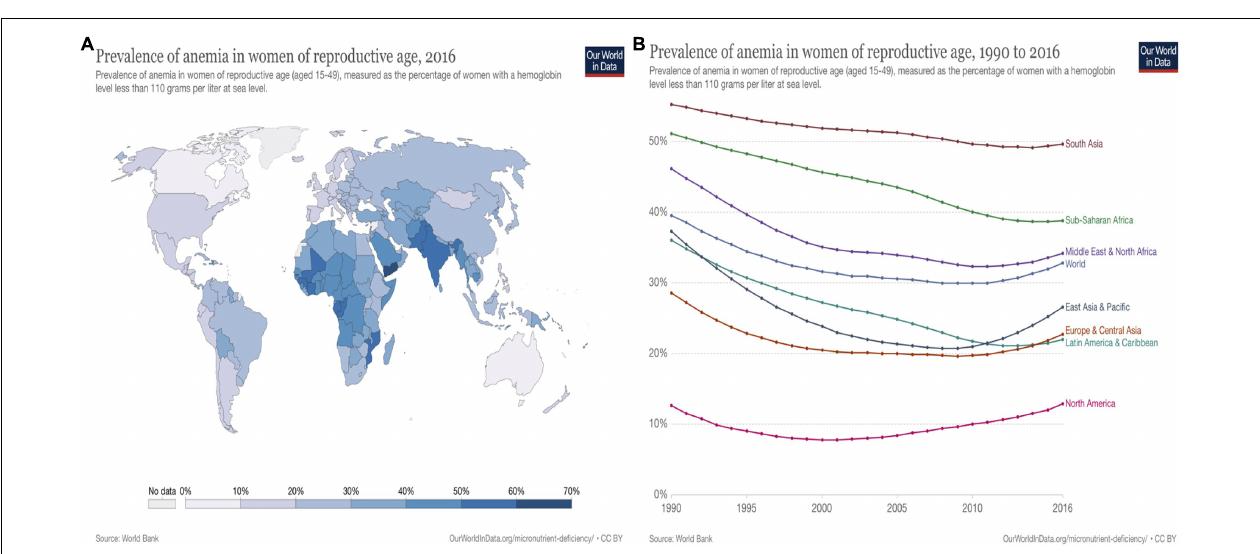
FIGURE 3 | Vitamin B12/Iron deficiency: Anemia prevalence in women of reproductive age worldwide (Source: WorldBank; Ritchie and Roser, 2017). (A) Vitamin B 12 /Iron deficiency: anemia prevalence in women of reproductive age worldwide, 2016. Anemia (vitamin B 12 /Fe deficiency) in women of reproductive age (aged between 15 and 49) mainly occurs in South Asia (24.2–69.6%) and Sub-Saharan Africa (23.2–59.1%), and Middle East and North Africa regions (23.4–49.5%). In particular, Yemen shows the highest rate with 69.6%. The prevalence of anemia in reproductive aged women occurs in comparatively low numbers in North America (9.5–14.6%), Latin America, the Caribbean (18.5–30.2%), Europe, and Eastern Asia (15.7–26.4%). (B) Vitamin B 12 /Iron deficiency: anemia prevalence in women of reproductive age worldwide, 1990 to 2016. Prevalence of anemia (Vitamin B 12 /Fe deficiency) has been decreased worldwide from 1990 to 2016 (39.60% to 34.23%). However, it slightly increased in several regions from 2013 to 2016 mainly in East and Central Asia, Pacific and Europe